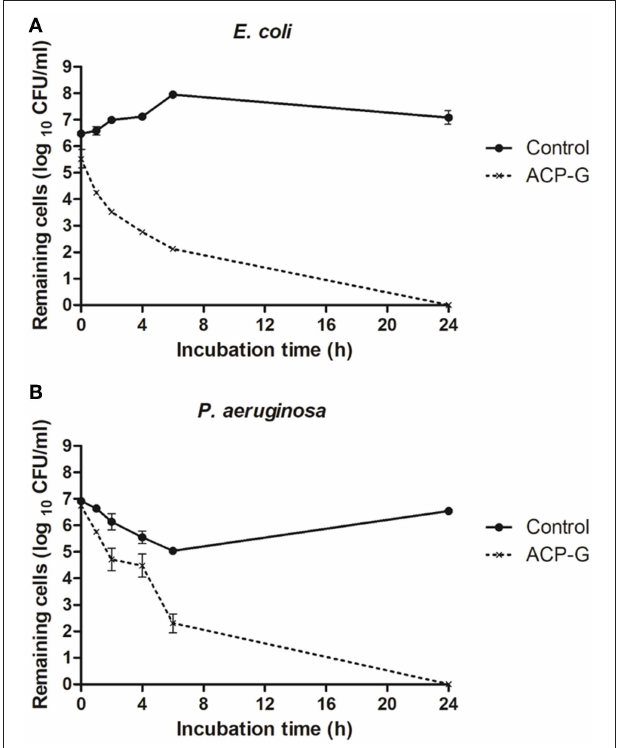
FIGURE 6 | Growth of planktonic cells of: (A) E. coli and (B) P. aeruginosa in presence of plasma-treated steel coupons (control) and steel coupons plasma-coated with gentamicin (ACP-G) submerged in